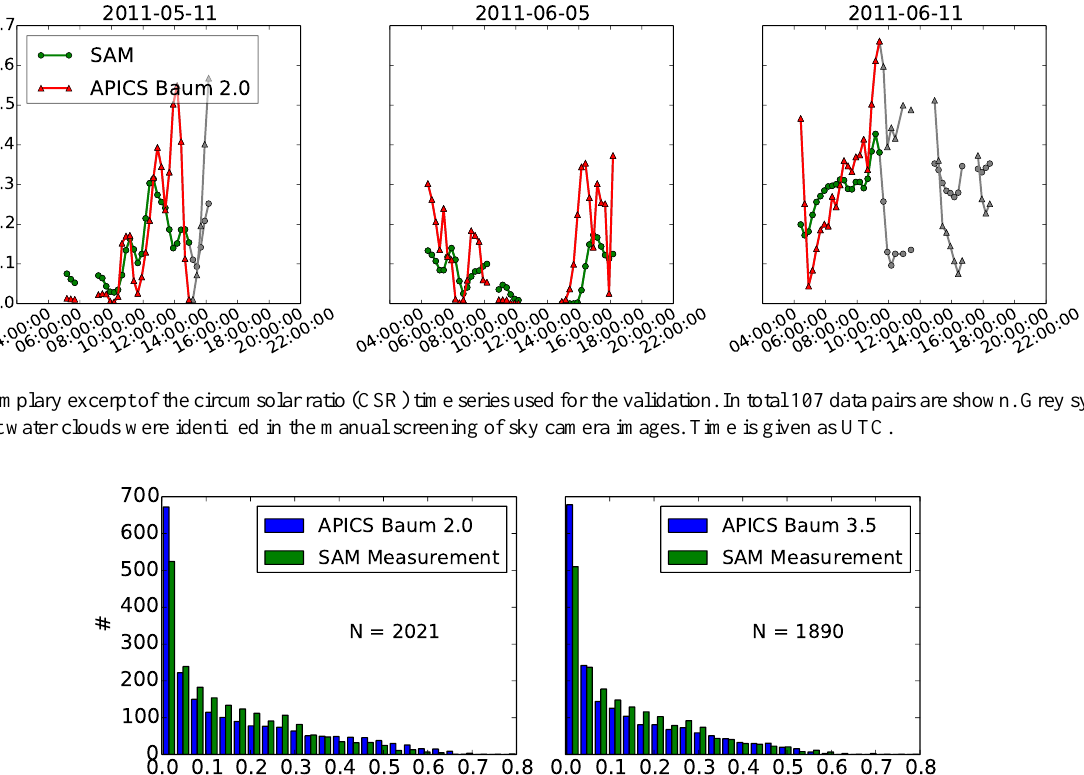
basis of all-sky images.